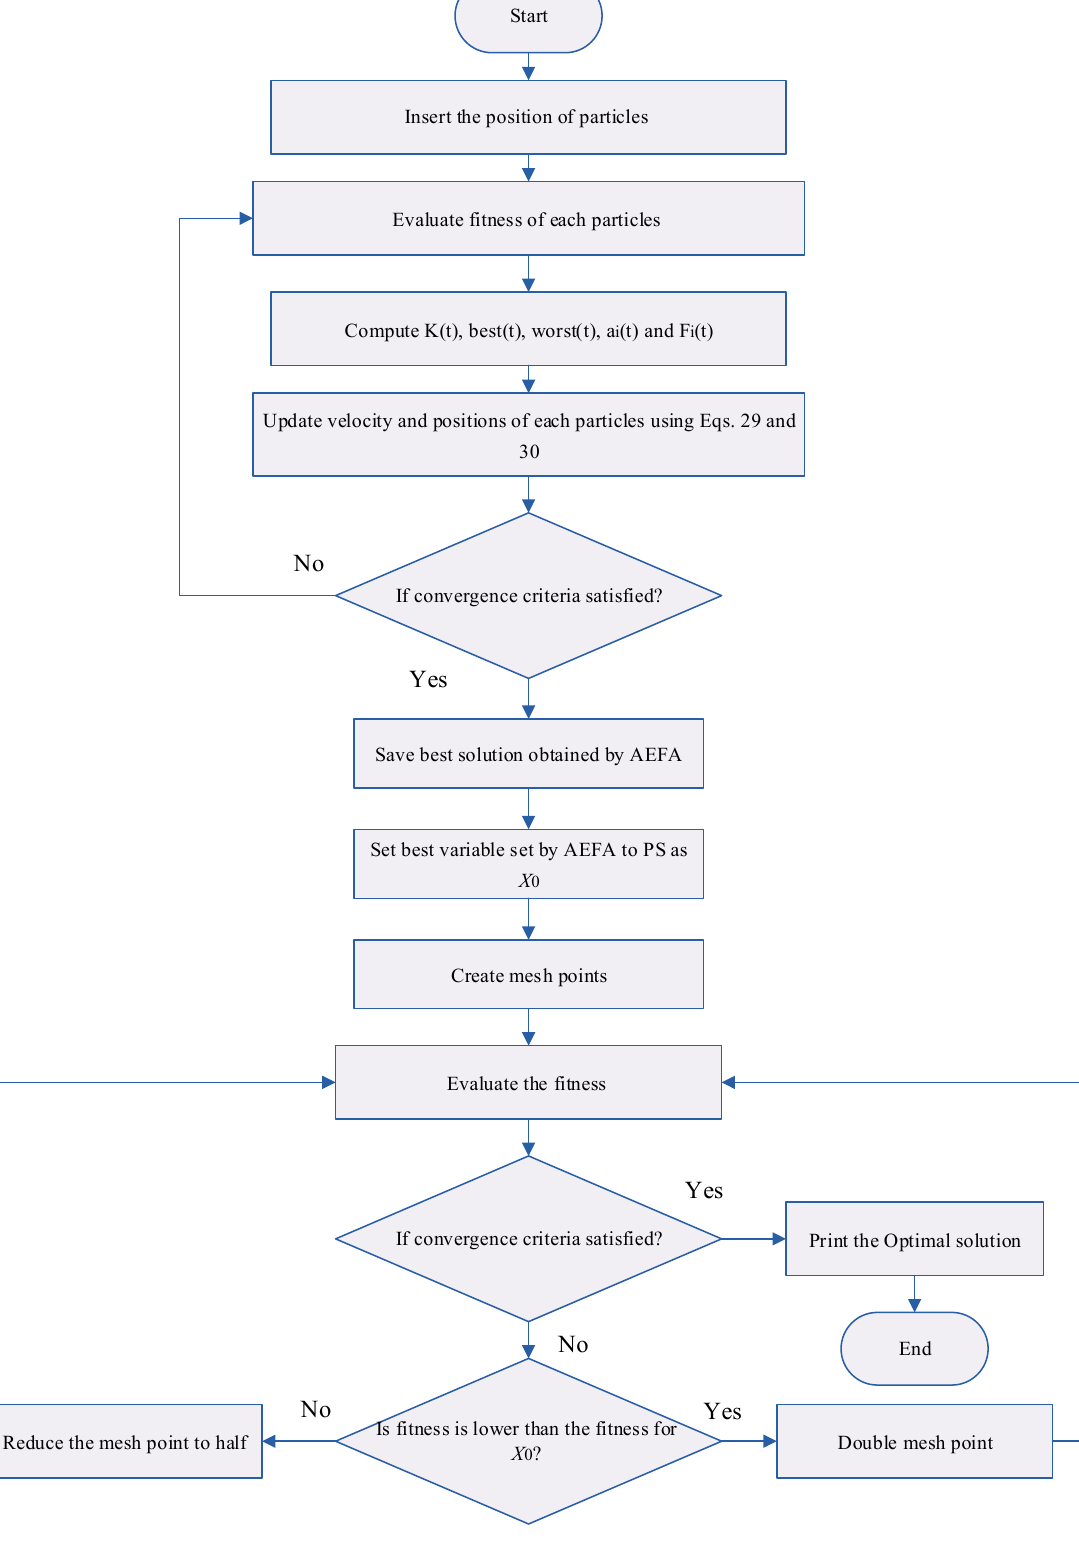
Figure 4. Flowchart of the AEFAPS method.